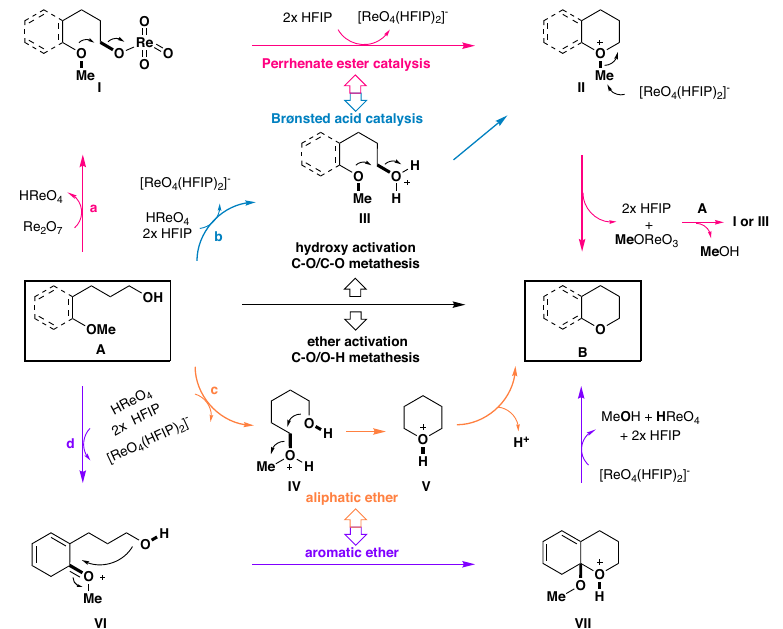
Fig.3|Plausiblereactionpathway.Hydroxyactivation.a Hydroxyactivationvia perrhenate ester formation (pink arrow). b Hydroxy activation via Brønsted acid